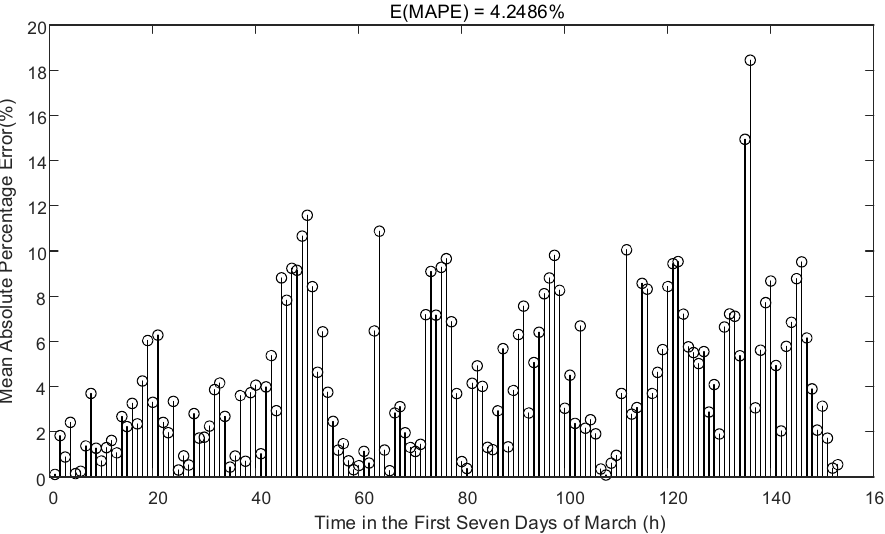
Figure 6. MAPE of the LSTM-T-A prediction results.